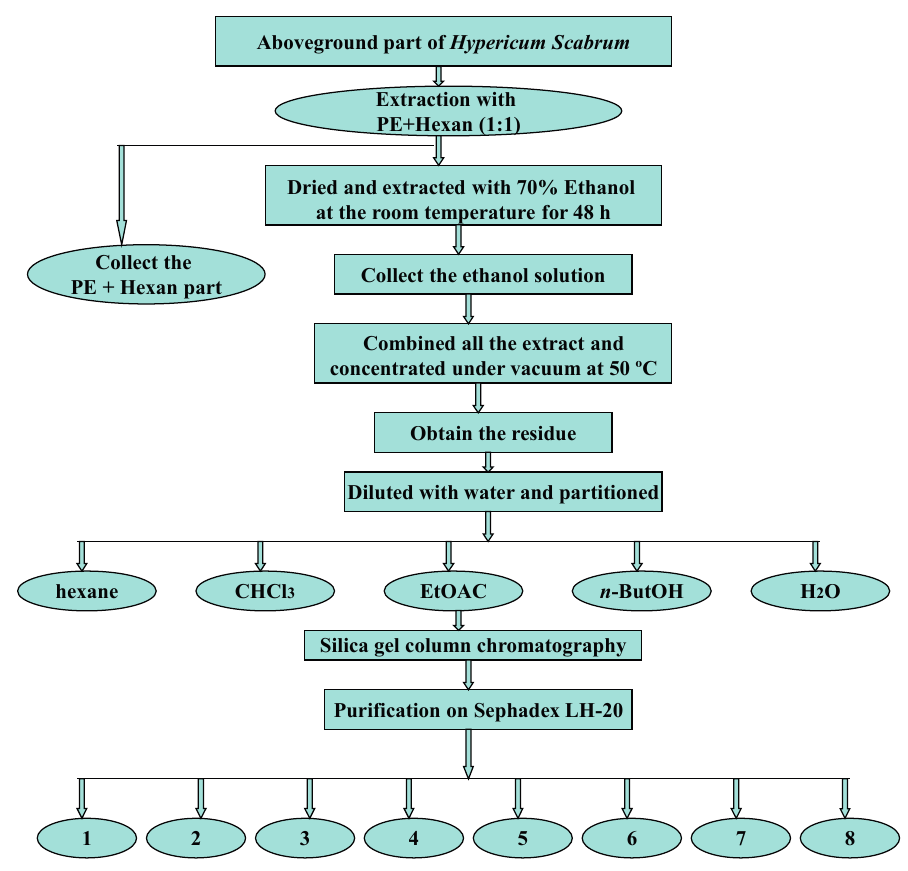
Figure 2. Flow sheet diagram of extraction, fractionation, isolation and purification of 1 to 8